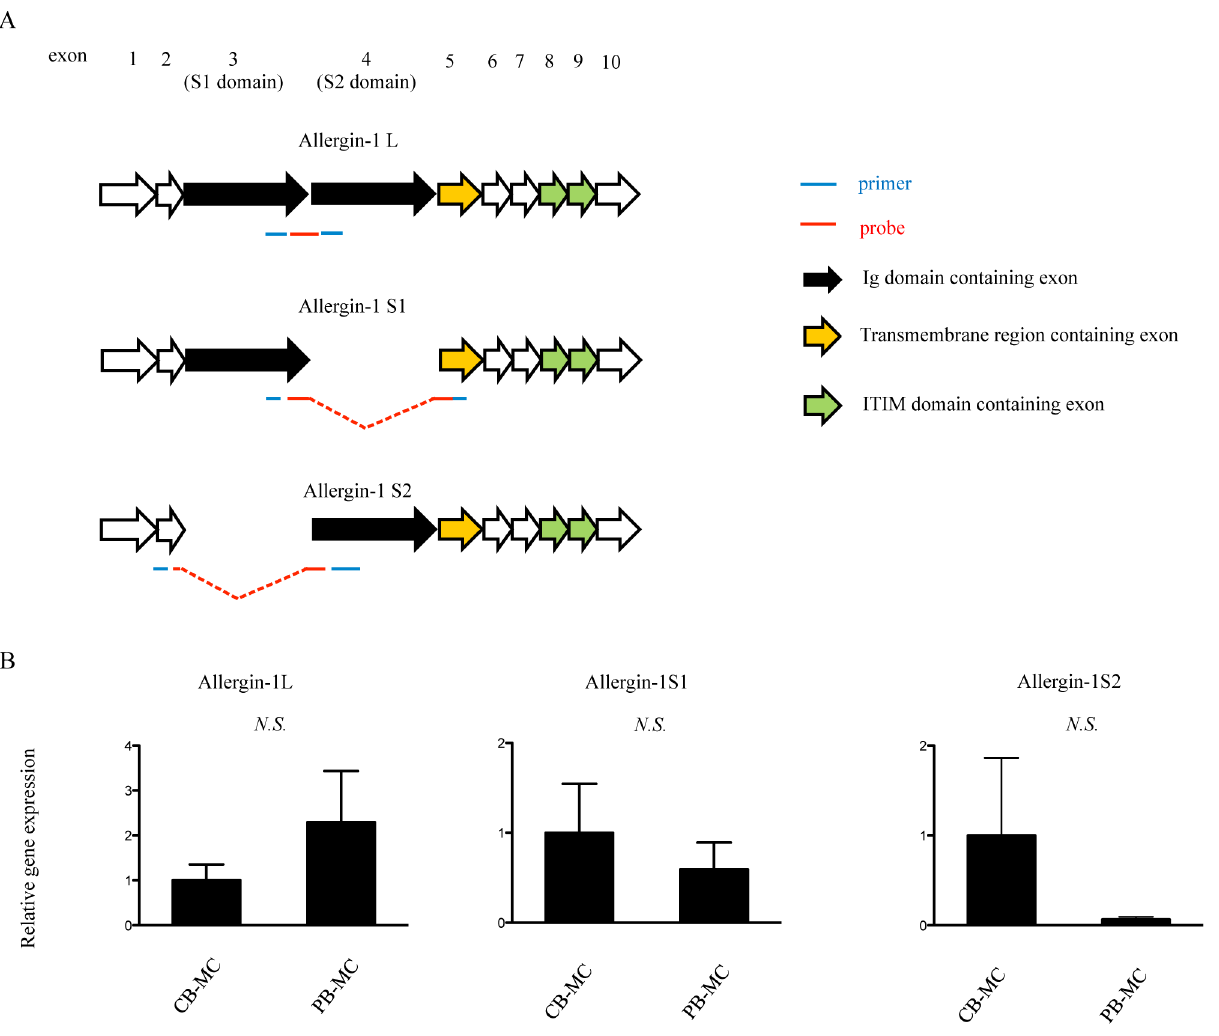
Figure 1. Expression of Allergin-1 isoform transcripts in cultured MC. A. Primers and probes for qRT-PCR were designed to detect Allergin- 1L, Allergin-1S1 or Allergin-1S2 mRNAs. B. CB-MC (n=3) and PB-MC (n=3) cultured for more than eight weeks were subjected to qRT-PCR, as described in Method.